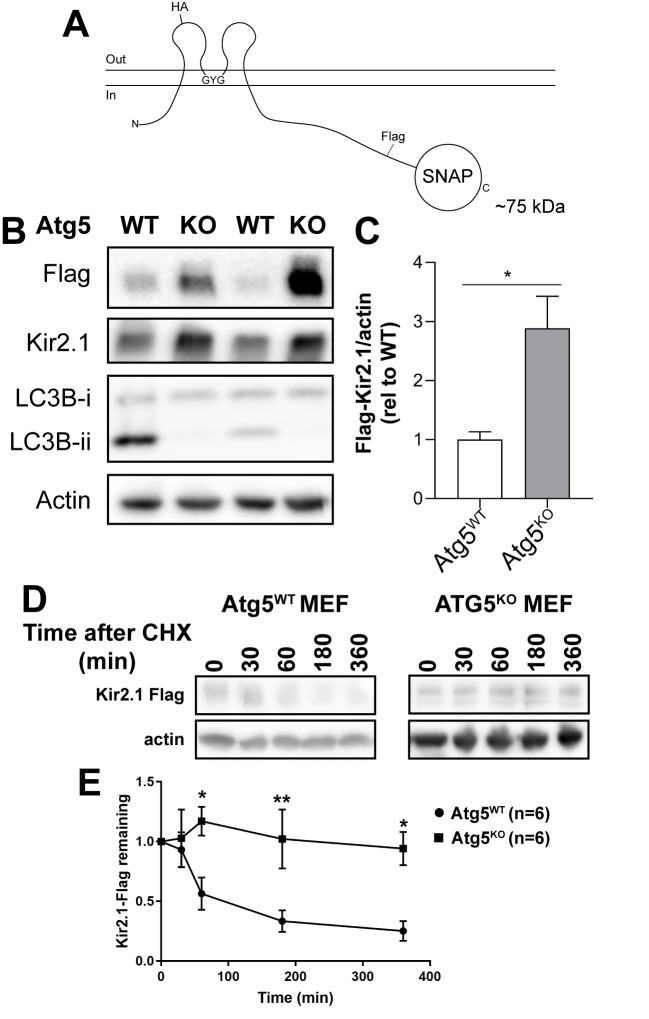
Higher steady-state levels of Kir2.1 and reduced degradation of Kir2.1 in Atg5KO MEFs.(A) Schematic of Kir2.1-externalHA-Flag-SNAP (abb. Kir2.1 below) construct. (B) Representative western blots and (C) quantification for Flag, Kir2.1, LC3B and actin show elevated steady state levels of Kir2.1 in transiently transfected in Atg5KO MEFs compared to Atg5WT MEFs. N = 3 per genotype. Data analyzed with two-tailed unpaired t test, t4 = 3.390, p = 0.0275. (D and E) Representative blots and aggregate data from six independent replicates per timepoint treated with cycloheximide at t = 0 min. Data were analyzed with a two-way ANOVA followed by Bonferroni post-hoc test. Time x genotype: F(4,44)=2.764, p = 0.0391. ns p>0.05, *p<0.05, **p<0.01, ***p<0.001, † p<0.0001.Figure 5—figure supplement 2—source data 1.Source Data for Figure 5—figure supplement 2B.Figure 5—figure supplement 2—source data 2.Source Data for Figure 5—figure supplement 2D.